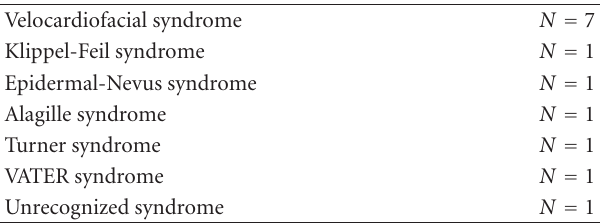
Table 2: Syndromic causes of noncleft